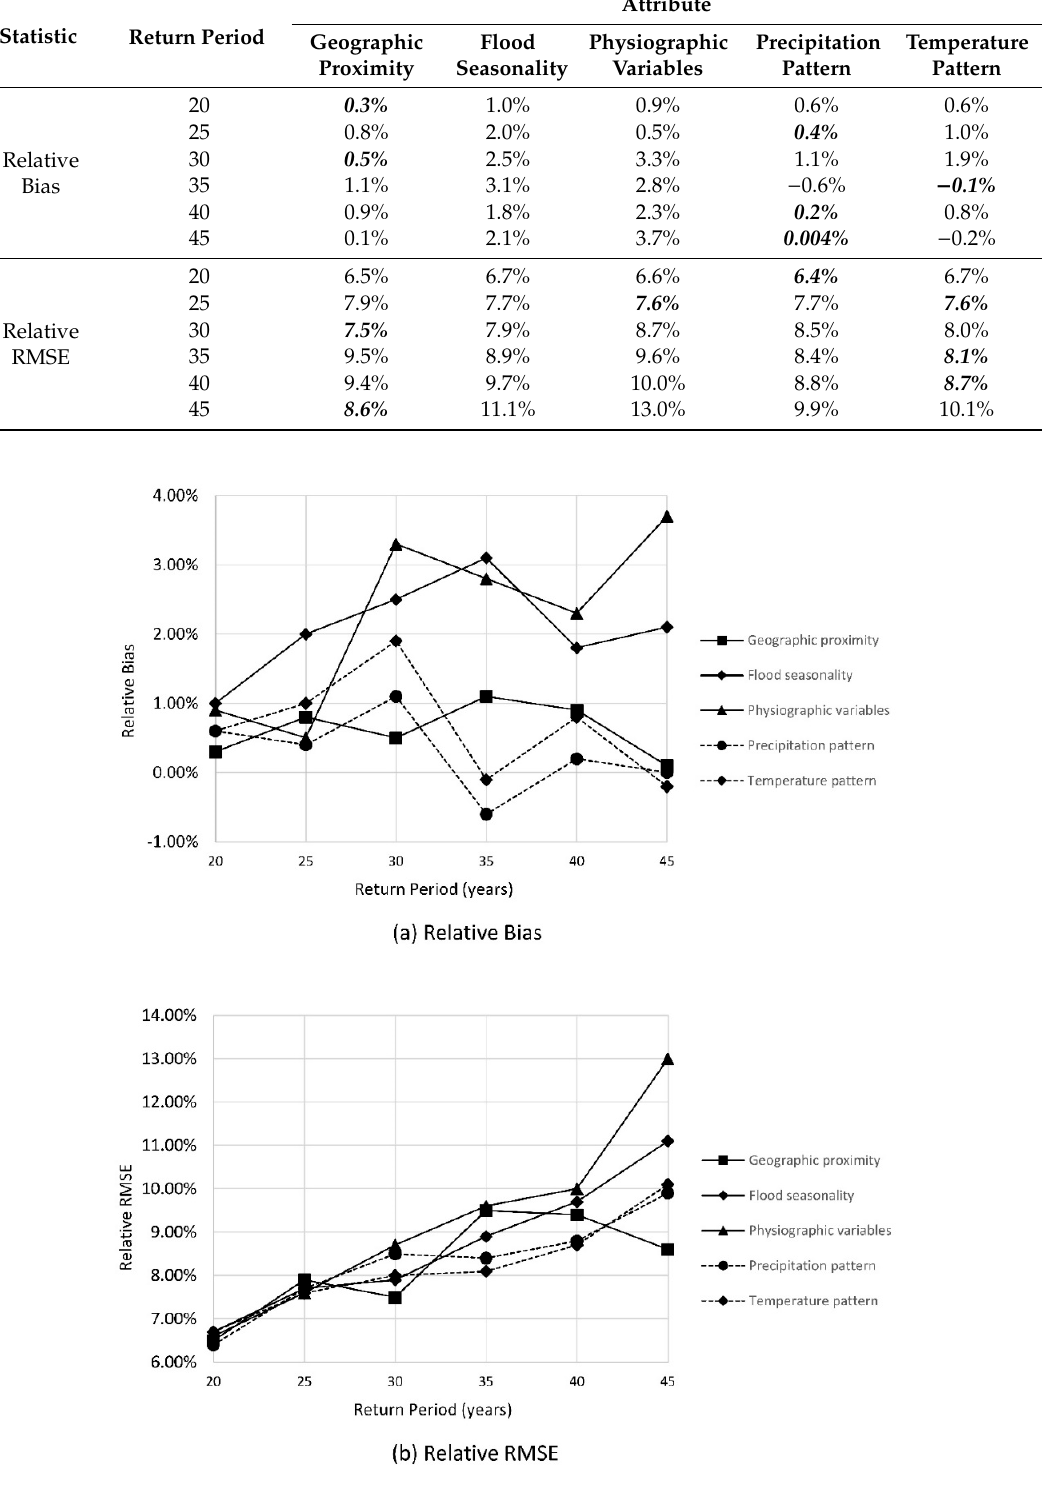
Figure 9. Relative bias and relative RMSE results by return period.